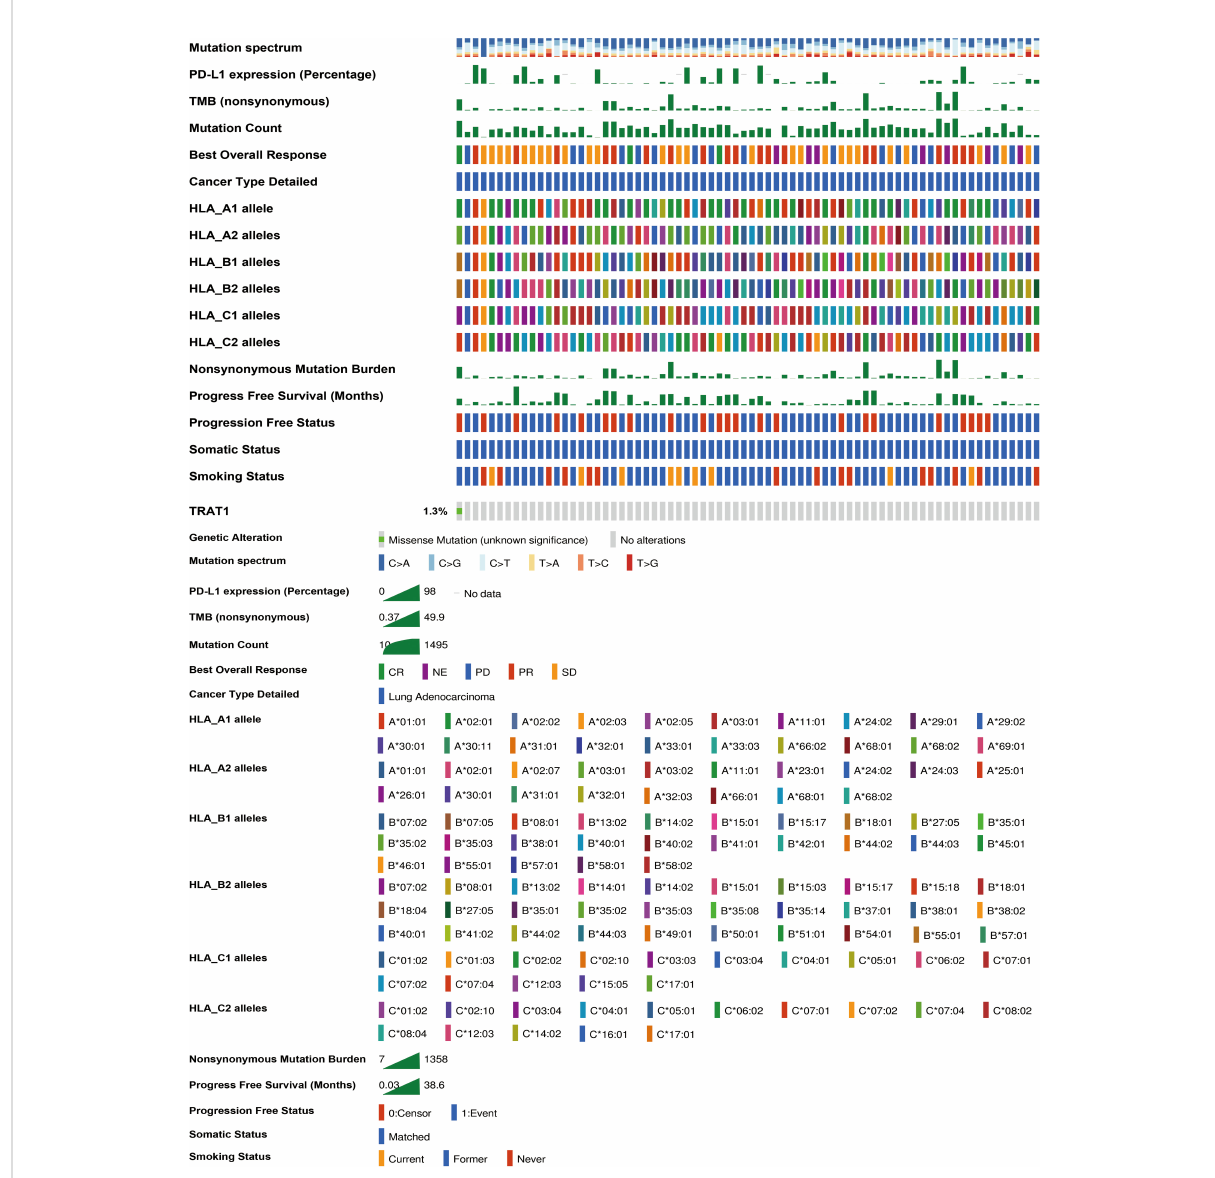
FIGURE 1 The relationship between TRAT1 expression levels and immune characteristics of LAC cells. LAC, lung